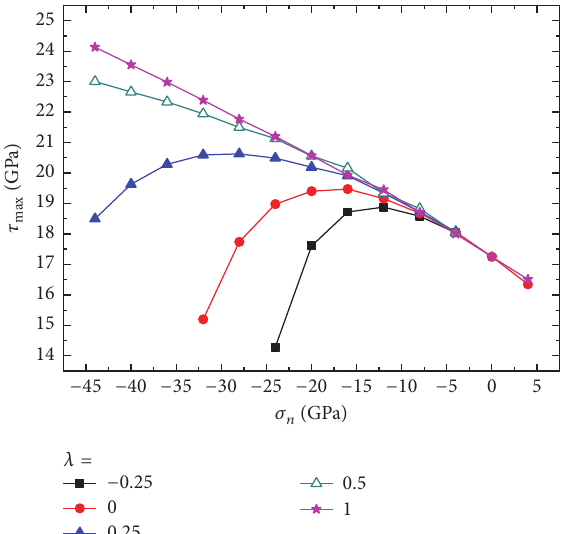
Figure 3: Evolution of the normal strains 𝜀 1 (open symbols) and 𝜀 3 (solid symbols) in the W crystal during shear straining. The circles illustrate evolution of the strains during the pure shear. The squares andtrianglesdisplaythedatapointscorrespondingtosuperimposed hydrostatic and uniaxial stresses of − 20GPa,